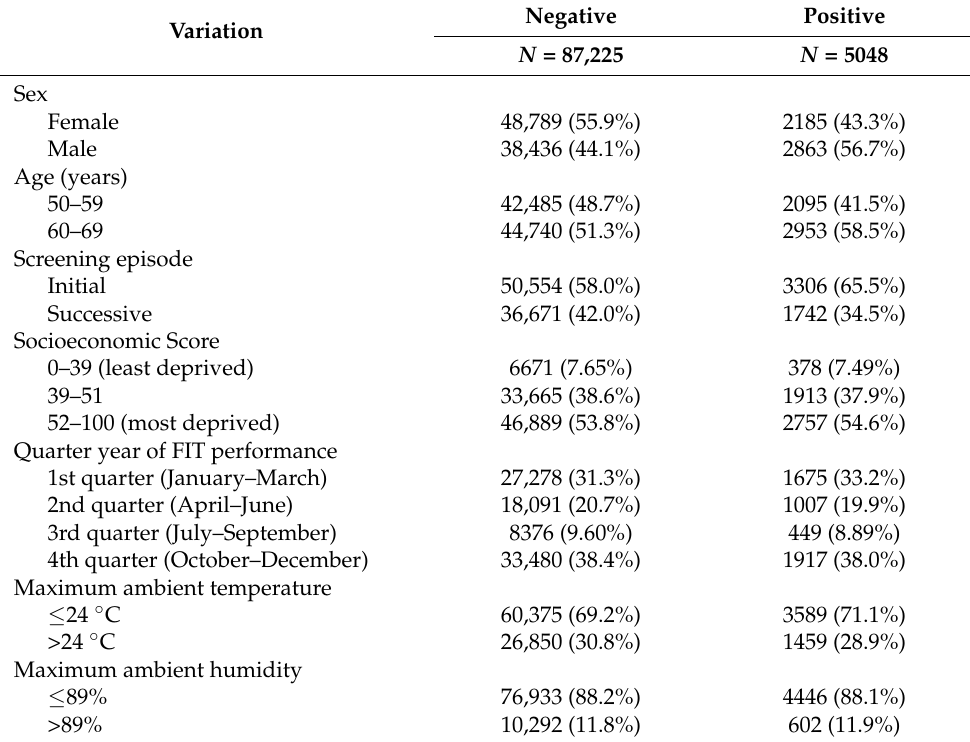
Table 1. Baseline characteristics of participants according to the FIT